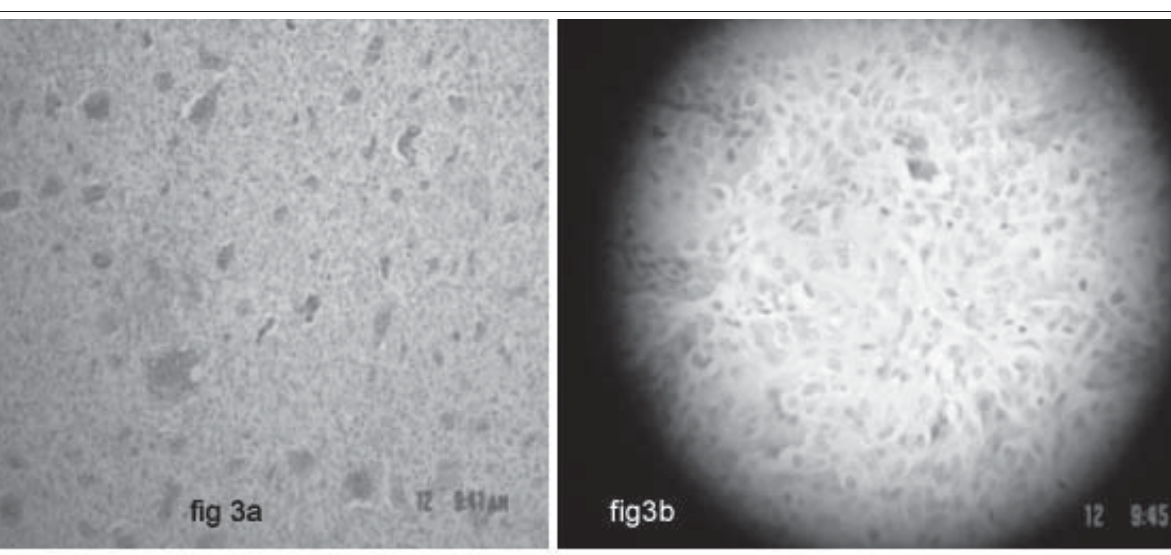
Figure 3a and 3b. Showing microscopy (200X H and E) revealing features of classical giant-cell tumor with the mononuclear (stromal) and giant-cell component. Focal area show preponderance of stromal cells